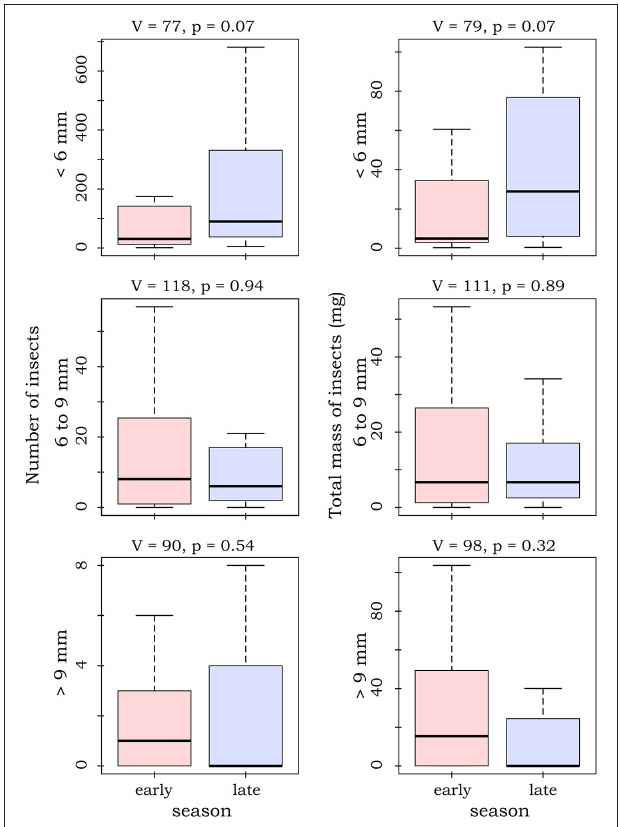
FIGURE 1 | Boxplots and test statistics for number of insects and dry mass for the different seasons, sorted by different size classes of insects. Whiskers depict at maximum 1.5 times the inter-quartile range. For graphical reasons outliers are not shown. Please see Table 1 for total numbers at the sampled